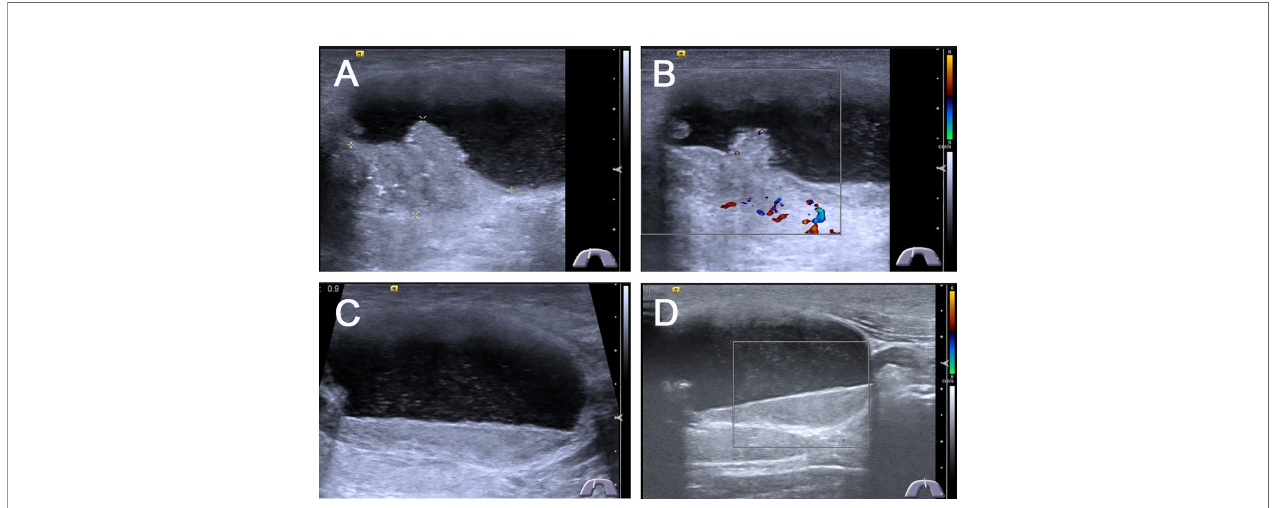
FIGURE 1 | Conventional ultrasonography images of predominantly cystic papillary thyroid carcinoma. (A) Longitudinal gray-scale sonography revealed a predominantly cystic 4.2 × 2.4 × 2.7 cm 3 thyroid nodule with a little solid portion abutted on the side of the cyst wall in the thyroid isthmus, the cystic portion was more than 90% of the thyroid node. (B) CDFI showed poor blood fl ow signals in the solid portion of the thyroid nodule. (C) Most portions of this thyroid node were cystic with a lot of mobile silt-like isoechoic substance. (D) CDFI showed no blood fl ow signals in the silt-like isoechoic